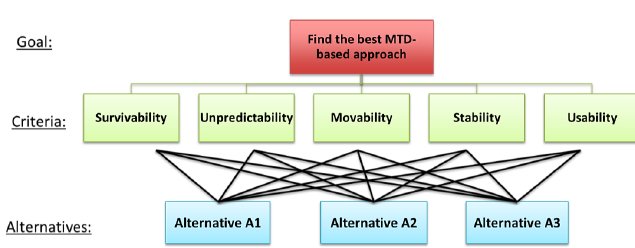
Figure 4. An AHP hierarchy to choose the best MTD